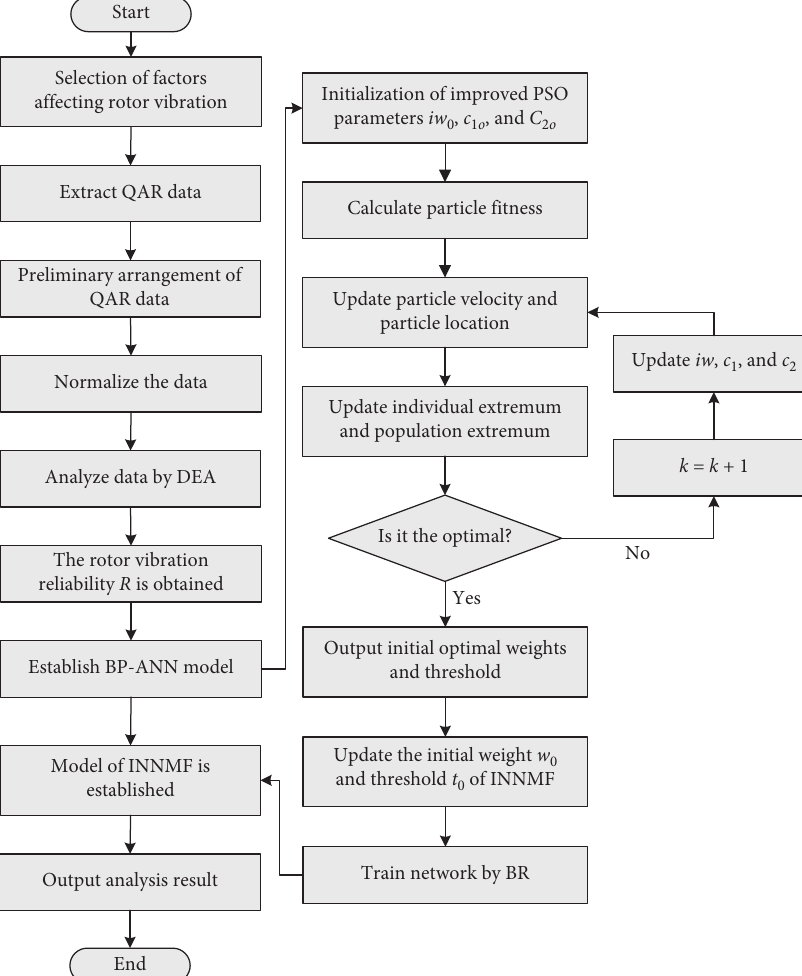
Figure 2: Flow chart of rotor vibration reliability analysis based on INNMF.